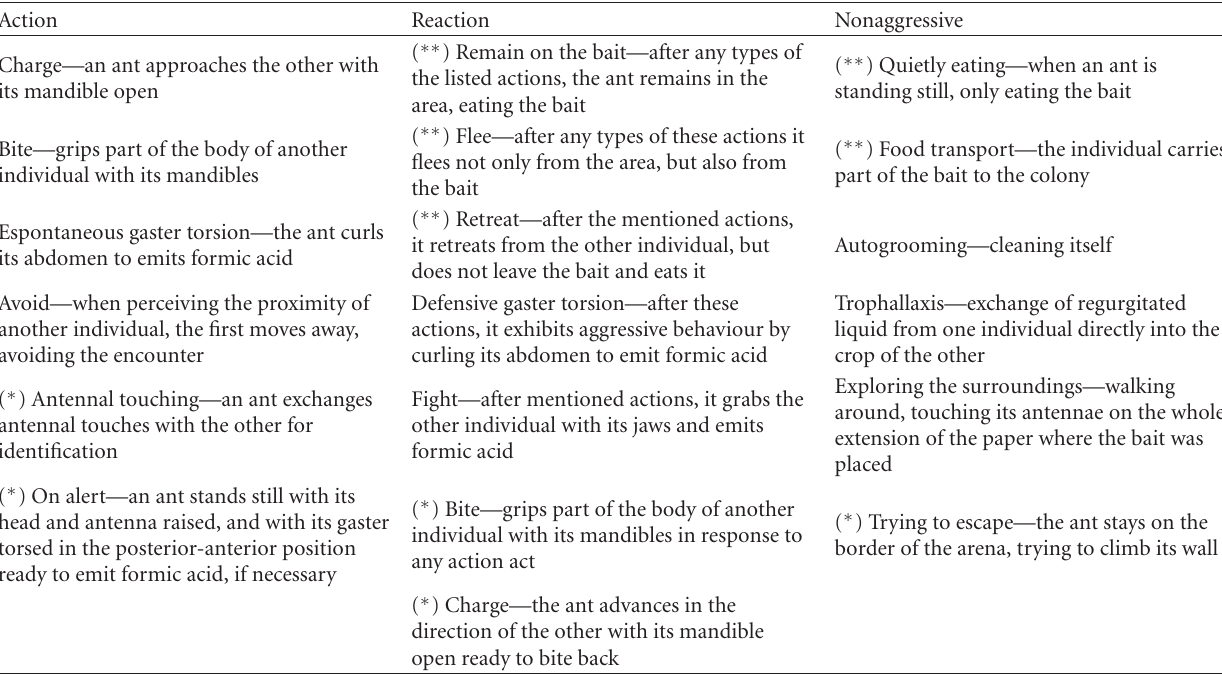
Table 3: Description of behavioral acts displayed by the ants on Itacolomi State Park (Itacolomi) and the Campus of Federal University of Juiz de Fora (UFJF) during field experiments ( ∗∗ ) and laboratory experiments (dyadic encounters) occurring at the lab of the Federal University of Juiz de Fora ( ∗